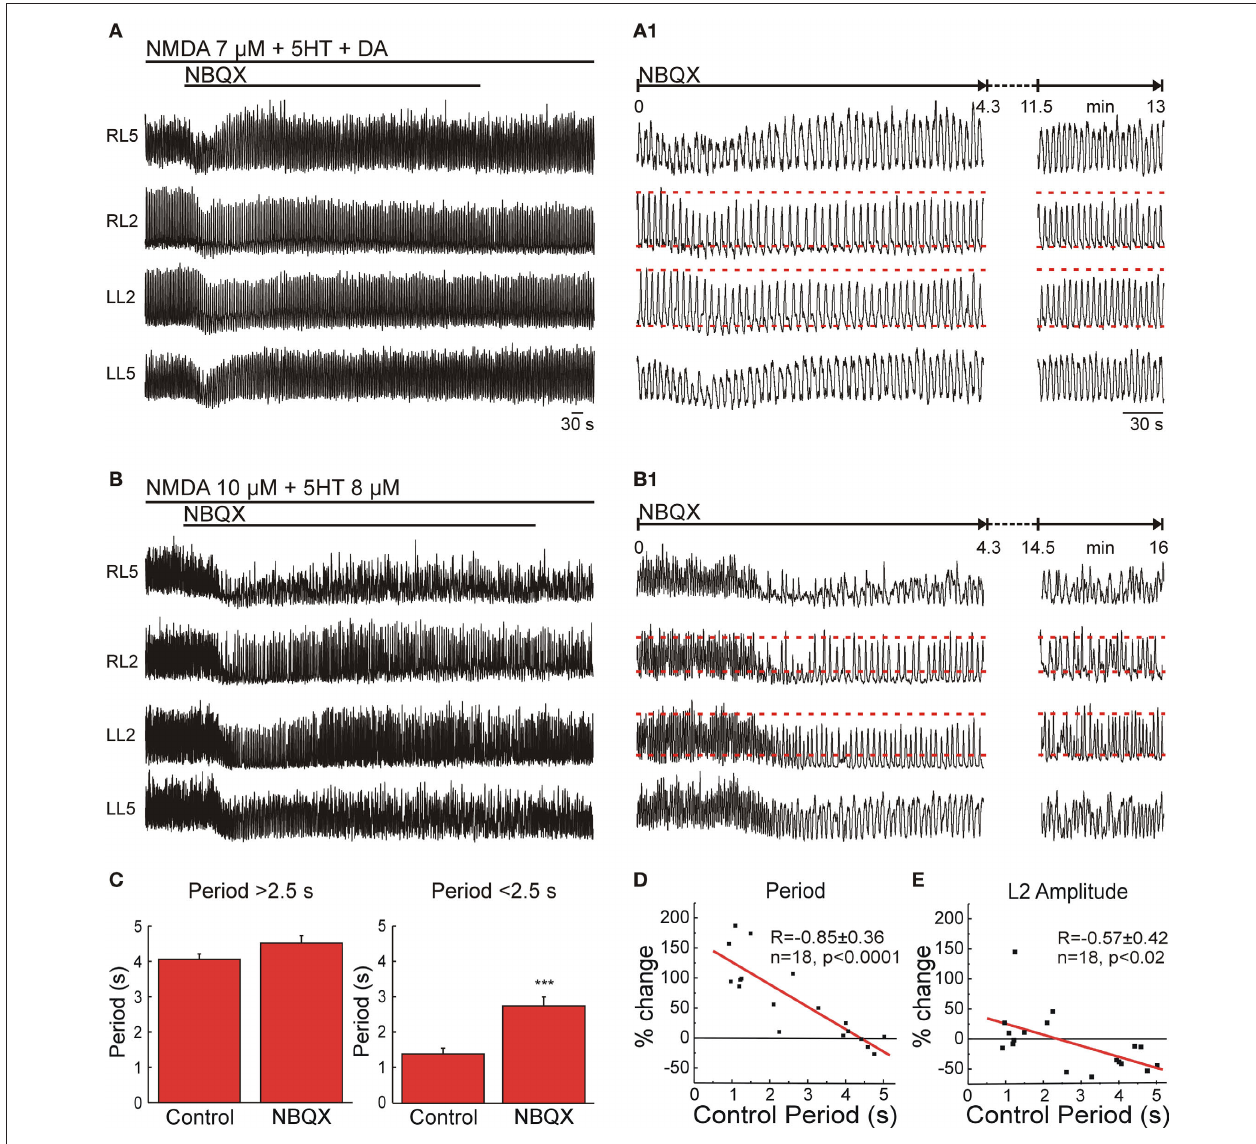
time there was a complete recovery of amplitude modulation but only partial recovery of frequency. (C) Statistical analysis of the effect of NBQX (10 μM) on locomotor period (Means ± SEMs, n = 9 for each condition, paired t -test, *** p < 0.001). (D) Plot of the difference in steady-state locomotor period (% change with respect to control) as a function of the control period showing a significant and linear inverse correlation for the effect of NBQX as a function of the control period ( n = 18). (e) Correlation of NBQX-induced difference in amplitude modulation of the L2 VR bursts (% of change with respect to control) as a function of the control period ( n = 18) showing a significant reduction of the amplitude at frequencies < 0.4 Hz and lack of effect of NBQX at higher